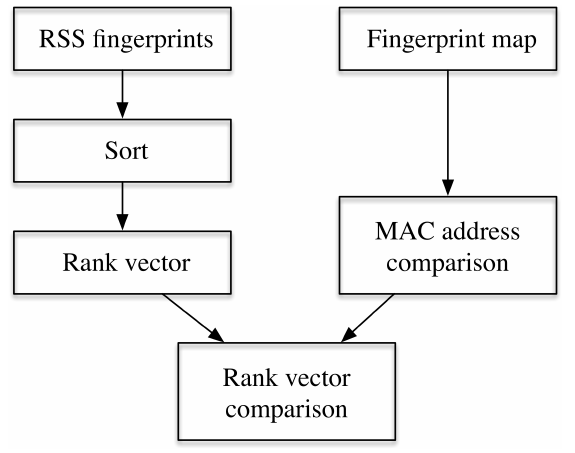
Figure 1. An implementation for calculating the rank based